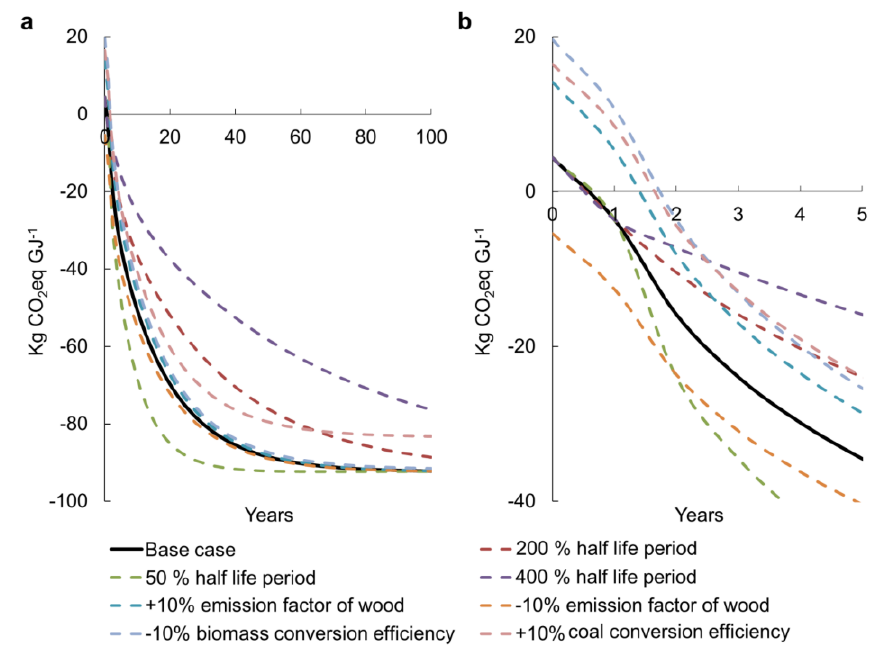
Figure 3. Greenhouse gas (GHG) emissions of wood displacing coal. ( a ) The net CO 2 savings per end-use energy under varying assumptions of key parameters; ( b ) equal to ( a ) but zoomed in. Figure taken from [45].